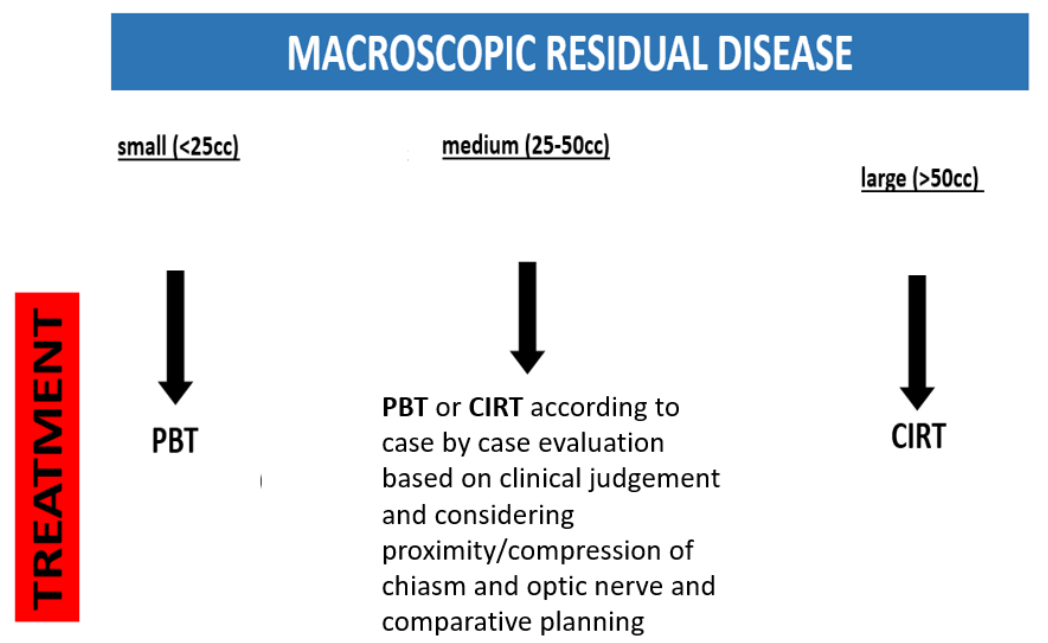
Figure 6. Present institutional treatment decision algorithm for PBT vs. CIRT based on the size of macroscopic residual disease, and involvement of critical structures PBT = proton beam therapy; CIRT = carbon ion radiotherapy.